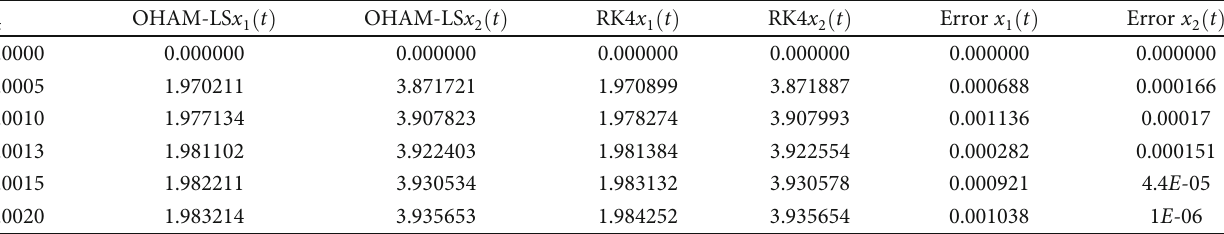
Table 2: Comparisons and absolute error between OHAM-LS and RK4, α = 1